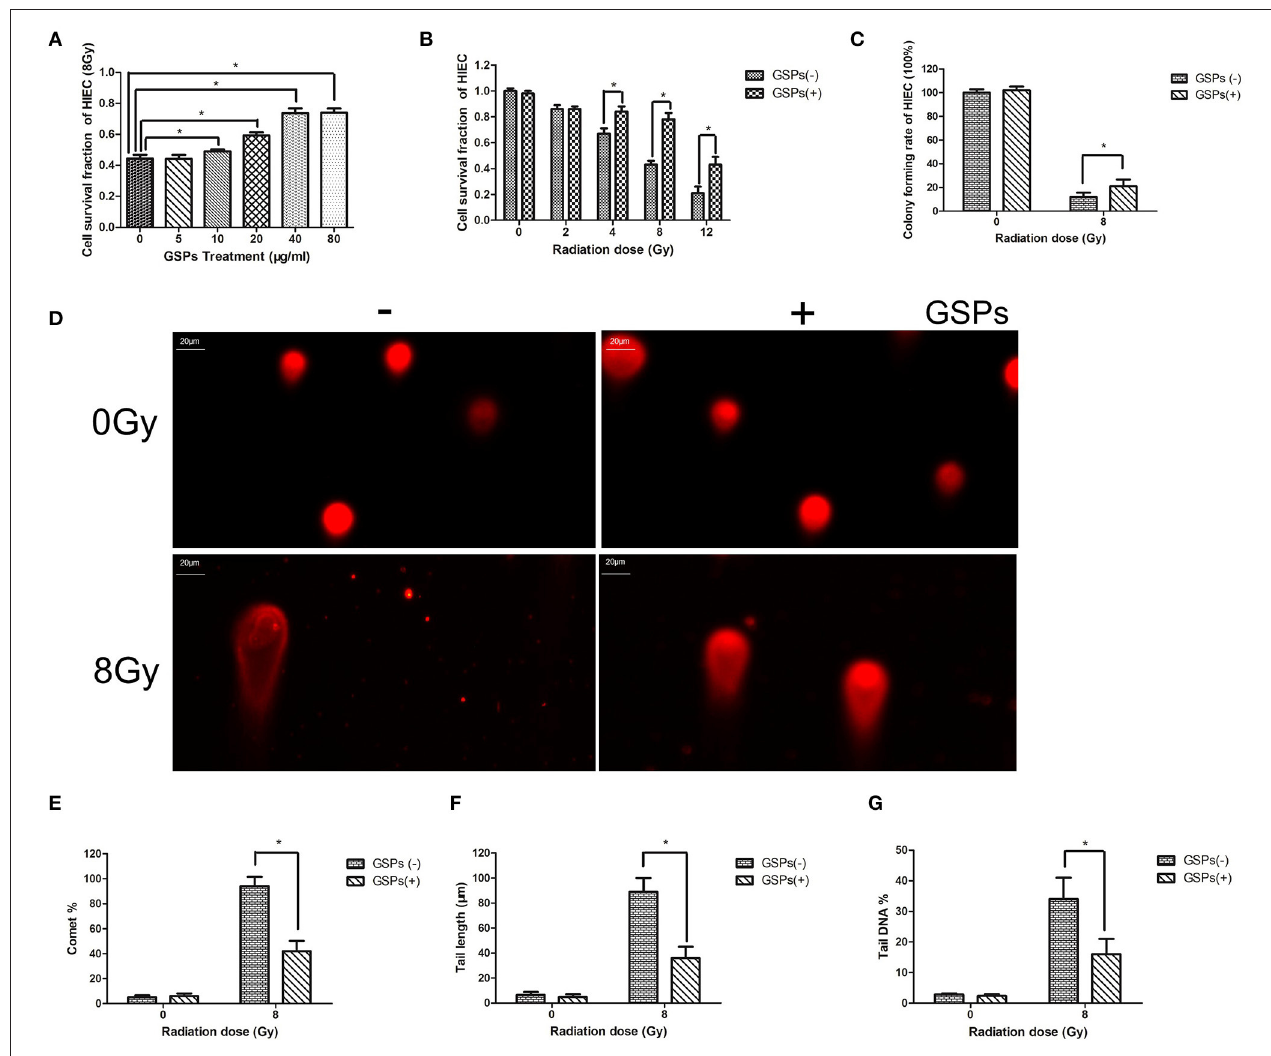
FIGURE 2 | GSPs have a radioprotective effect on human small intestinal crypt epithelial cells HIEC. (A) When HIEC cells are exposed to 8Gy IR, GSPs exert a dose-dependent radioprotective effect. (B) The viability of HIEC cells gradually decreases with the increase of the radiation dose, while GSPs increase the vitality of irradiated HIEC cells. (C) The clone formation assay shows that GSPs increase the proliferation ability of irradiated HIEC cells. (D–G) Effect of GSPs in HIEC cells on IR-induced DNA strand breaks assayed by comet assay. (D) Representative micrographs. (E) Comet%. (F) Tail length. (G) Tail DNA%. Data are presented as mean ± SD ( n = 6). * P <